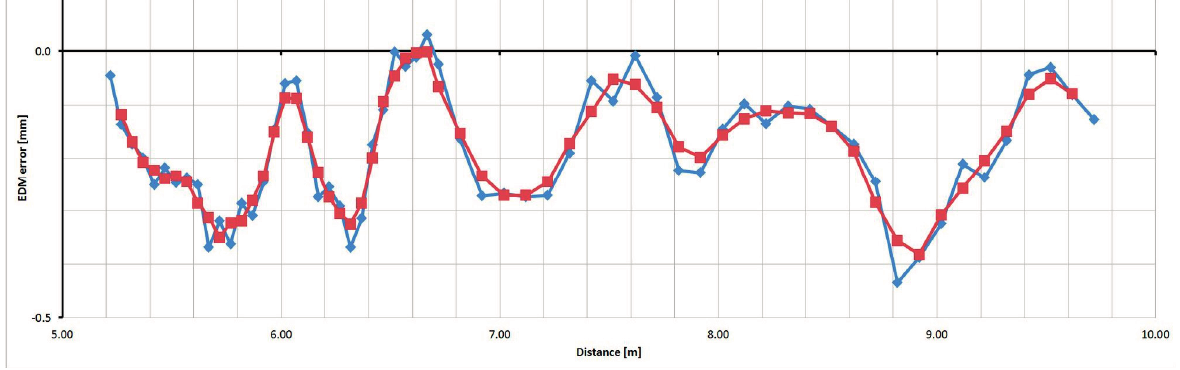
Figure 31. Relative errors of the Leica TC1202 instrument (measured blue, averaged